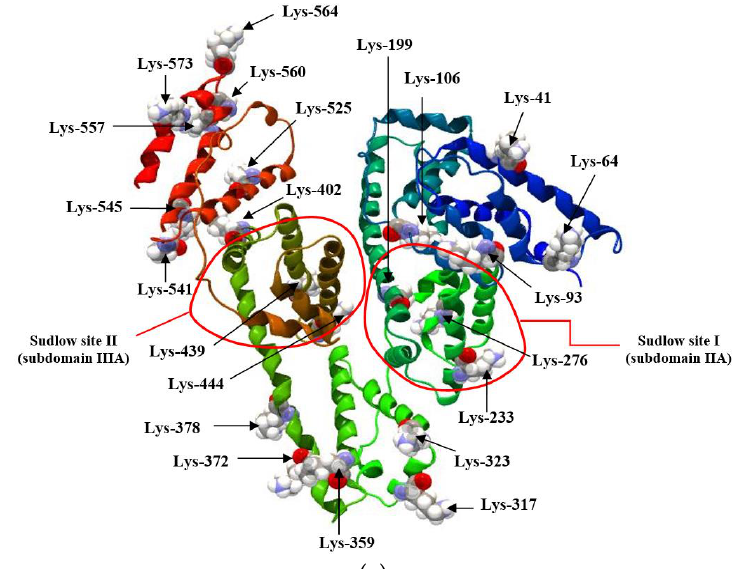
Figure 1 . Cont . Figure 1.